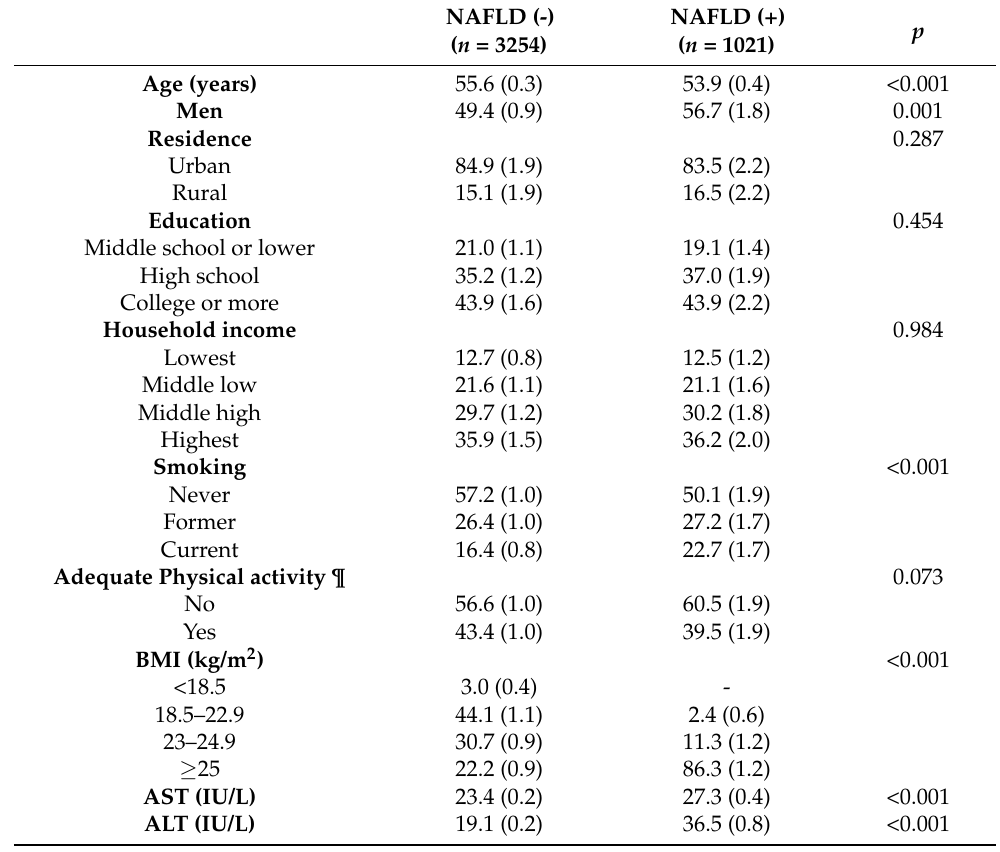
Table 1. Characteristics of study